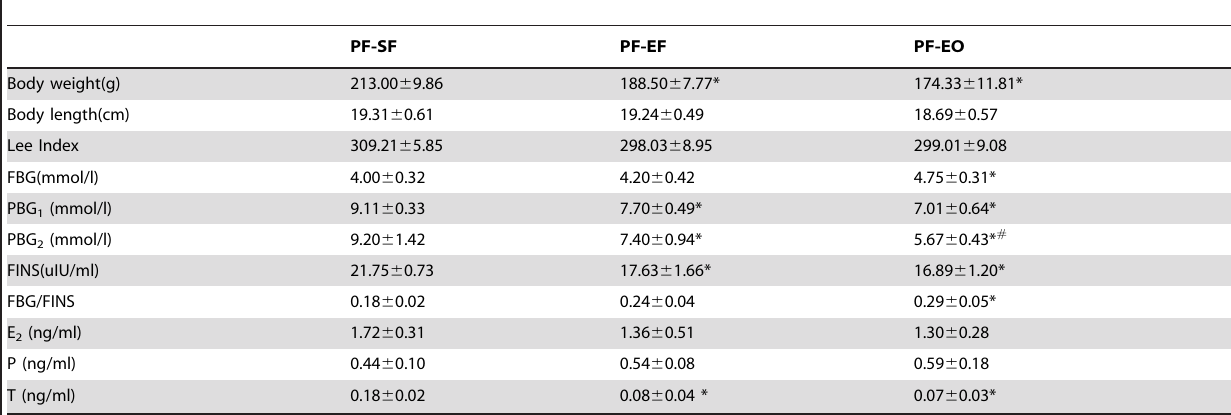
Table 3. Effects of exercise and diet on metabolic and endocrine variables in PF